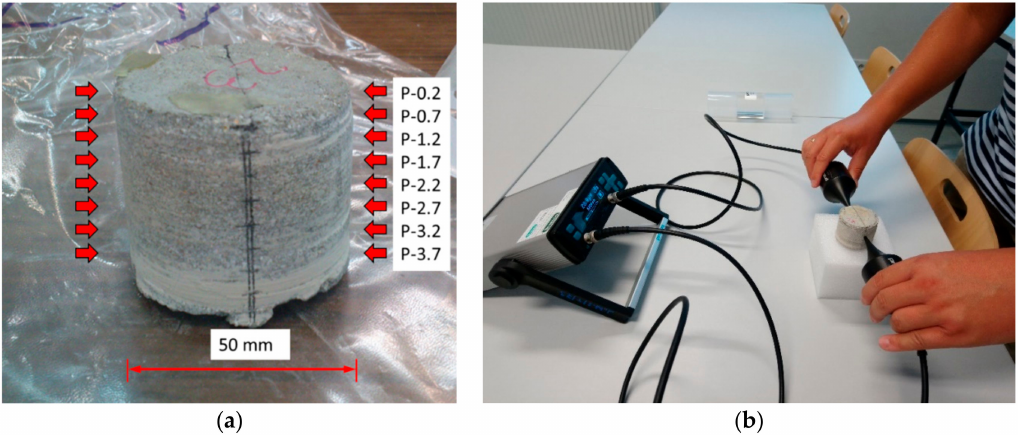
Figure 3. The ultrasonic method: ( a ) the arrangement of measuring points on a core sample for testing the longitudinal velocity of the ultrasonic wave c L along the thickness of the cement mortar used to make the overlay; ( b ) the view of the core sample during the